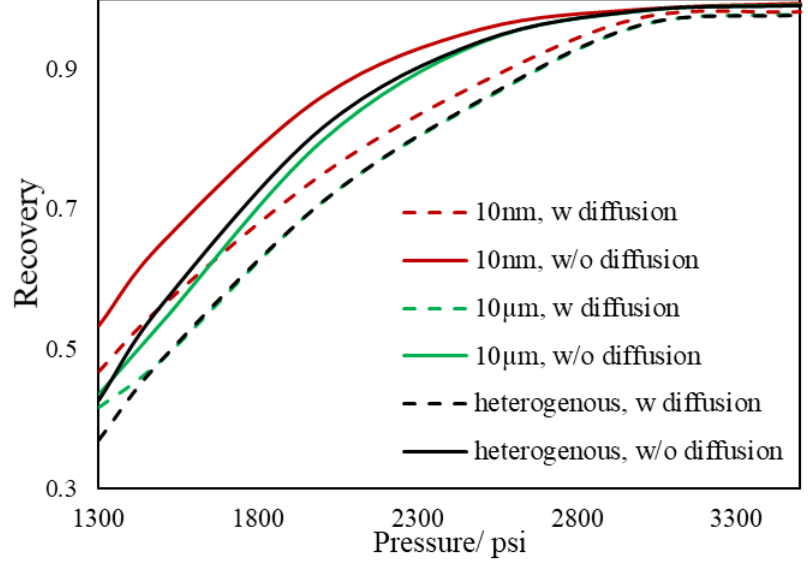
Figure 16. C 5 -C 6 Composition recovery as a function of pressure with and without di ff usion for slim tube simulation, Bakken, 10 µd.